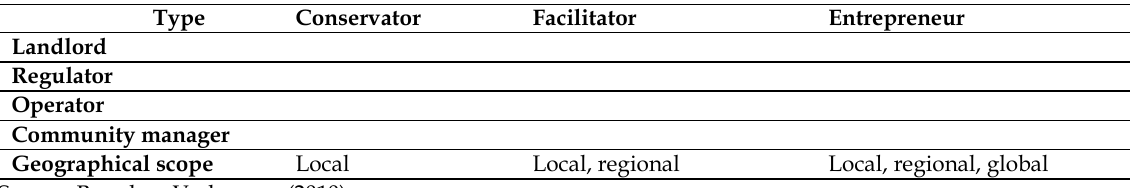
Port authority ‘renaissance